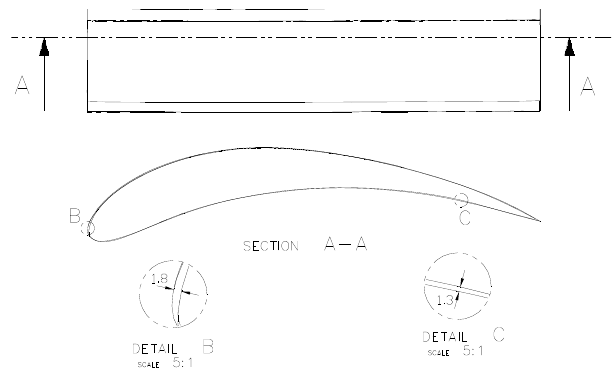
Fig 8. Comparison of surfaces created from photogrammetric and tacheometer measurement data at the cross section of the largest